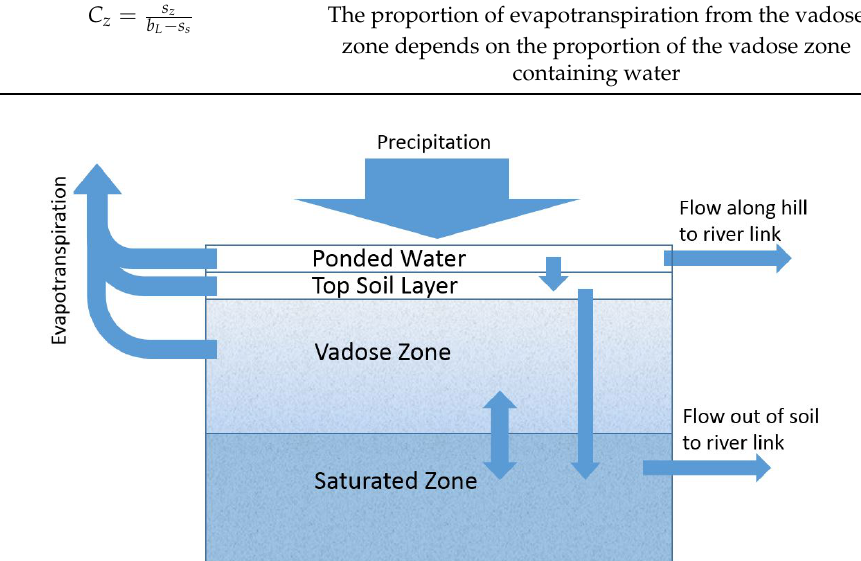
Figure 2. The soil model is described by Equation